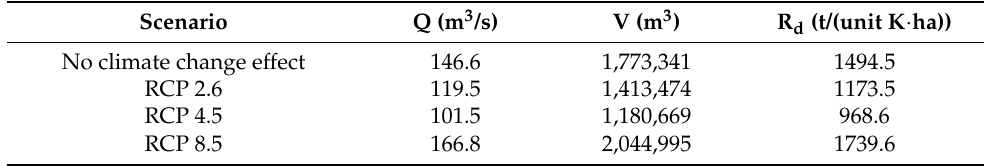
Table 5. Peak flow rate (Q) and volume (V) and event runoff factor (R d ) for the various scenarios, considering the flood event generated by 4 September 2011 rainfall event and using AMC III to produce surface runoff at Sarnico station.